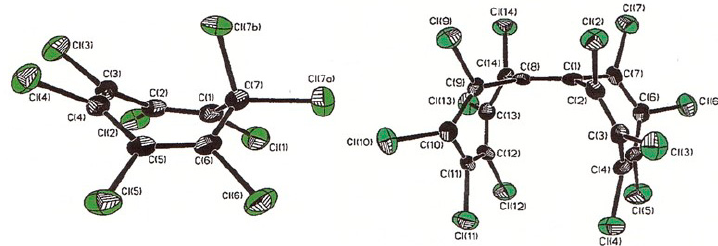
Figure 16. Structures of ( left ) octachlorocycloheptatriene, 40 , and ( right ) dodecachlorofulvalene, 43 . Figure 16 is reprinted from the Canadian Journal of Chemistry; © Canadian Science Publishing or its licensors.